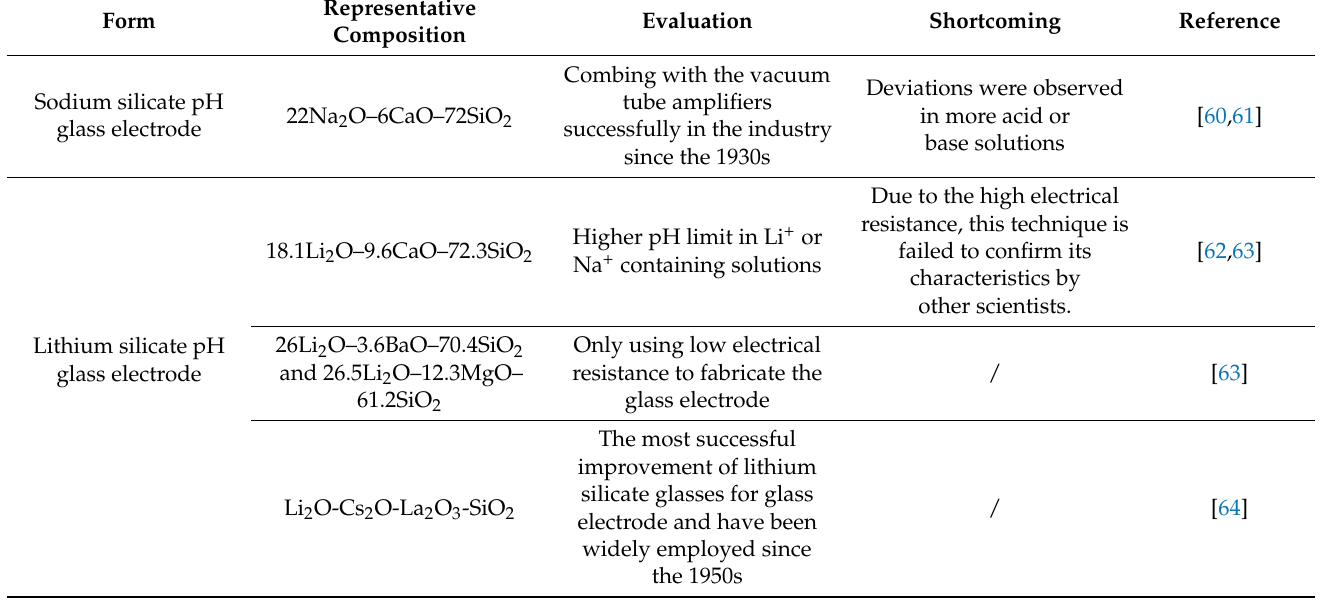
Table 1. The development of glass electrodes.